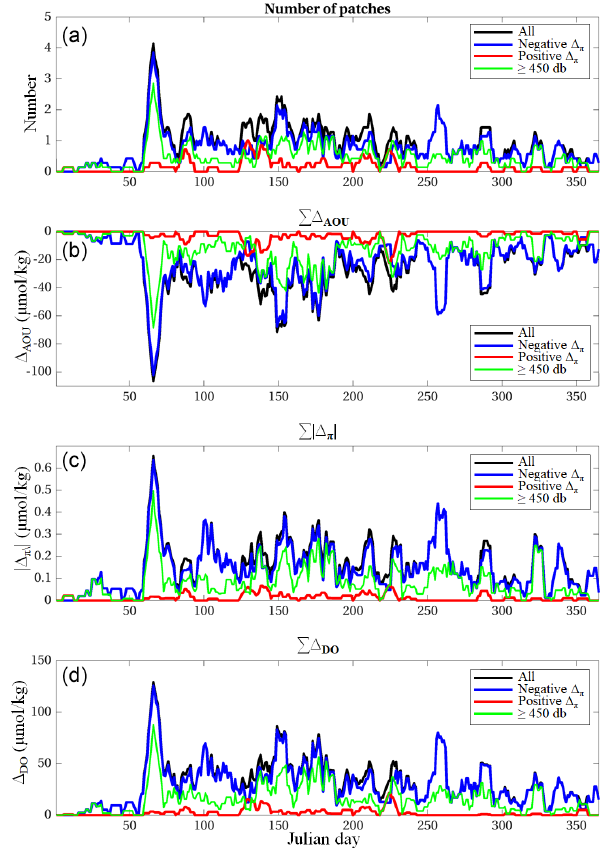
Figure 6. Temporal distribution of the number of patches (a) , inte- grated AOU anomaly (b) , integrated π anomaly (c) , and integrated DO anomaly (d) , by the Julian day based on 7-point smoothing. Spicity in subducted patches can be lower or higher than the sur- rounding waters, resulting in negative (cid:49)π (red lines) or positive (cid:49)π (blue lines) anomalies, respectively (see text in Sect. 3.4). The integrated anomalies indicate the significance and prevalence of the episodic subduction events over